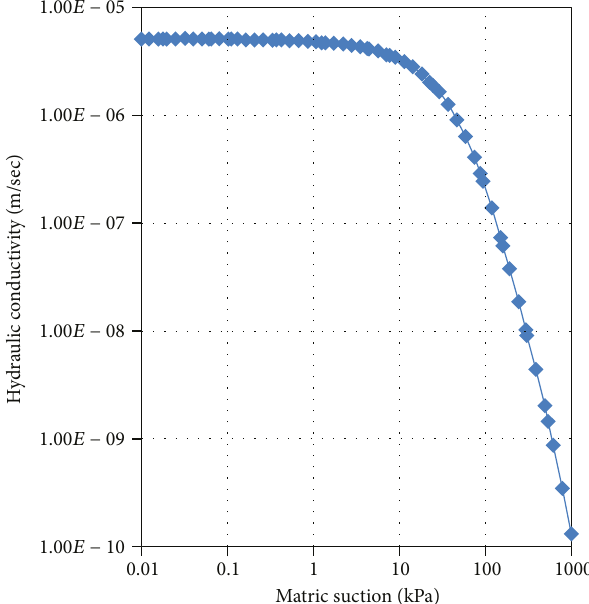
Figure 17: Nonsaturated permeability curve of the Hongyanzi landslide.